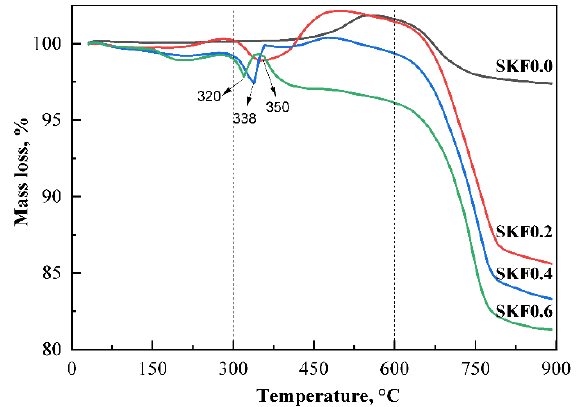
Figure 11. Thermogravimetric analysis of the used SKFx (x = 0, 0.2, 0.4, 0.6) catalysts when heated to 900 °C under 20% O 2 atmosphere.